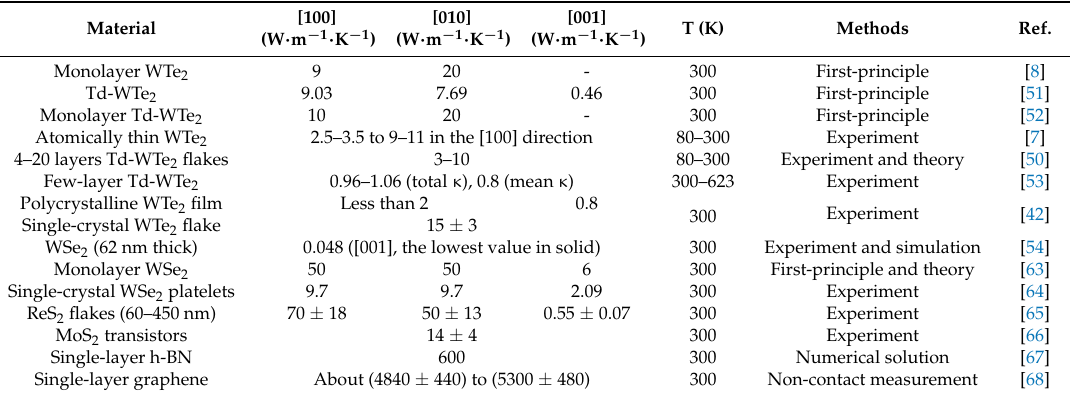
Table 1. The thermal conductivities κ of WTe 2 along different